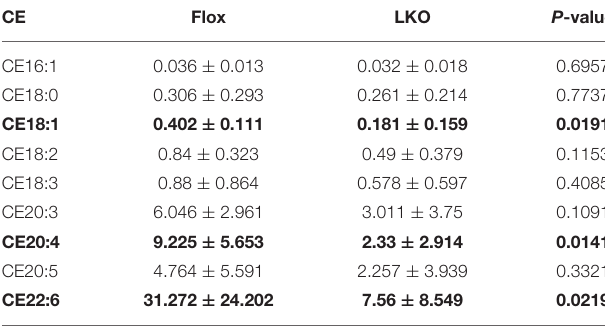
virtually depleted lipid droplets in the adrenal gland, which could explain the color change observed in the adrenal gland of Surf4 LKO mice.